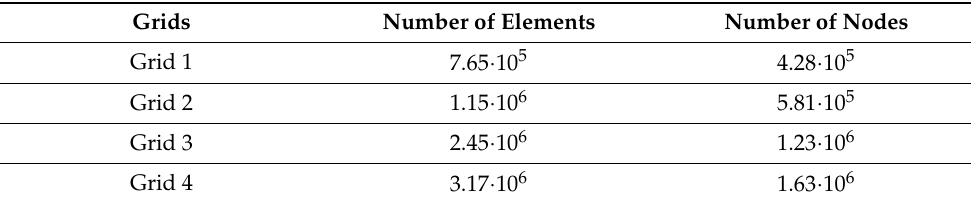
Figure 4. ( a ) and ( b ) grid sections with tetrahedral elements, ( c ) grid segment with hexahedral elements. Table 1. Number of Elements and Nodes for the Tested Numerical Grids.